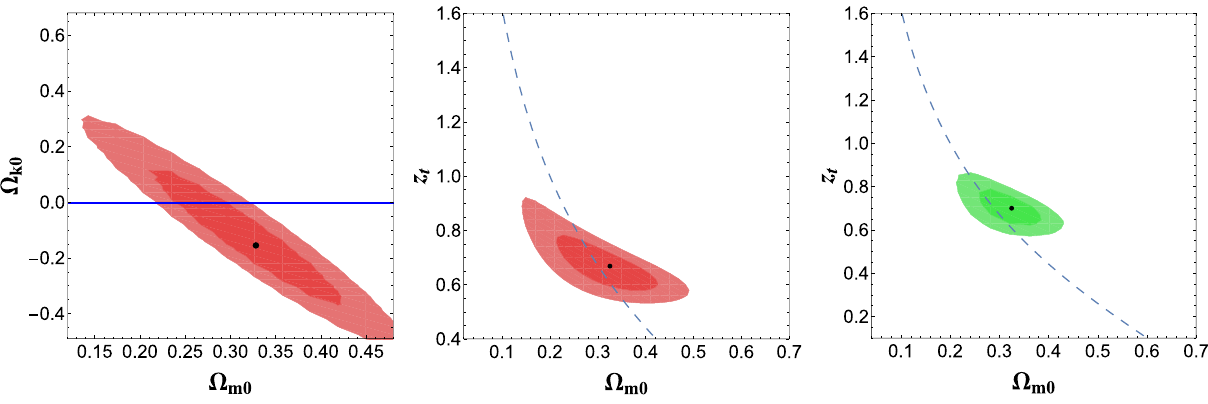
Fig. 3 In the figure on the left we show a strong degenerescence between the curvature parameter and the matter density parameter. In the central figure we show observational constraints updated for the